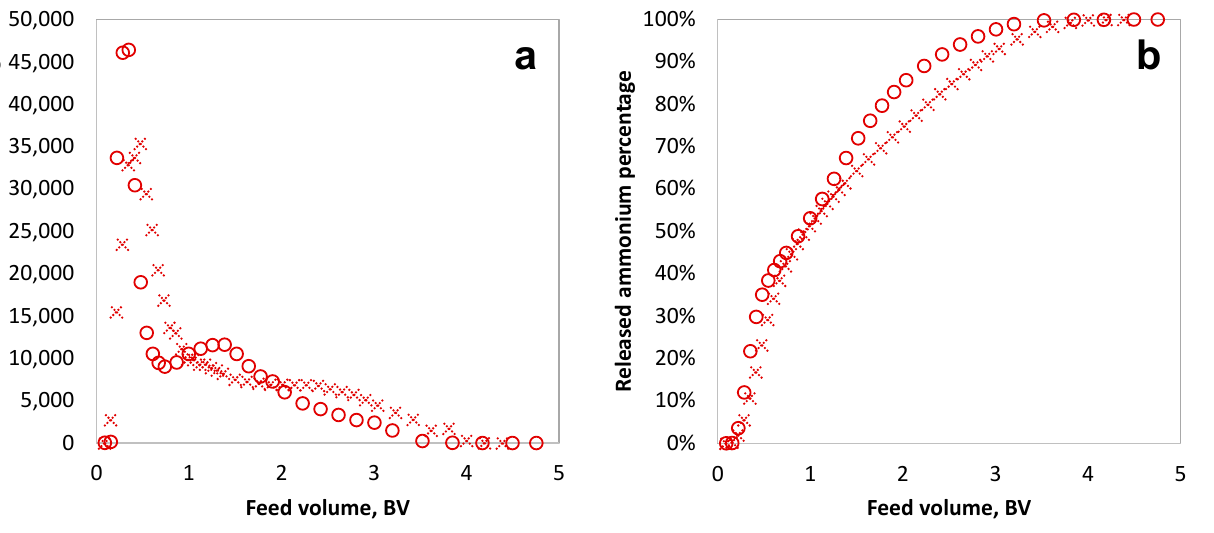
Figure 2. ( a ) Ammonium concentrations during the regeneration of CS16GC resin with K 3 PO 4 , ( b ) the regeneration efficiency. ( V bed = 35.34 mL, Q = 2 BV/h, at 60 °C, resin was pre-saturated with 1 mol/L NH 4 Cl). Dash-line crosses: 1 mol/L K 3 PO 4 ; solid-line circles: 2 mol/L K 3 PO 4 .